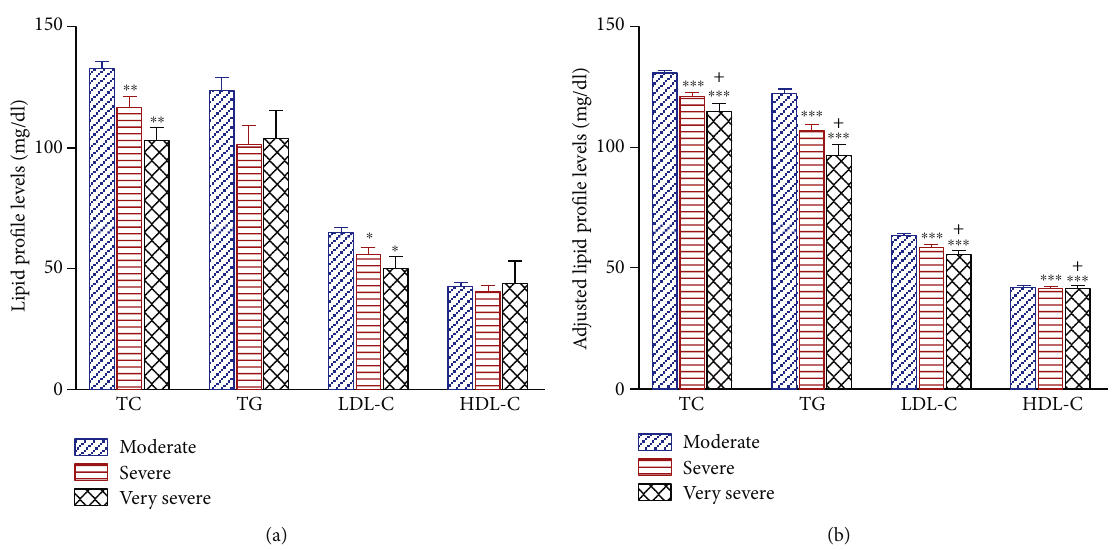
Figure 1: Mean + SEM of lipid pro fi le levels of (a) baseline and (b) adjusted for the Charlson comorbidity index in moderate (blue), severe (red), and very severe COVID-19 patients (dark). TC: total cholesterol; TG: triglyceride; LDL-C: low-density lipoprotein-cholesterol; HDL- C: high-density lipoprotein-cholesterol. ∗∗∗ P < 0 : 001 , moderate vs. other group. + P < 0 : 05 , severe vs. very severe. For each group, n = 5